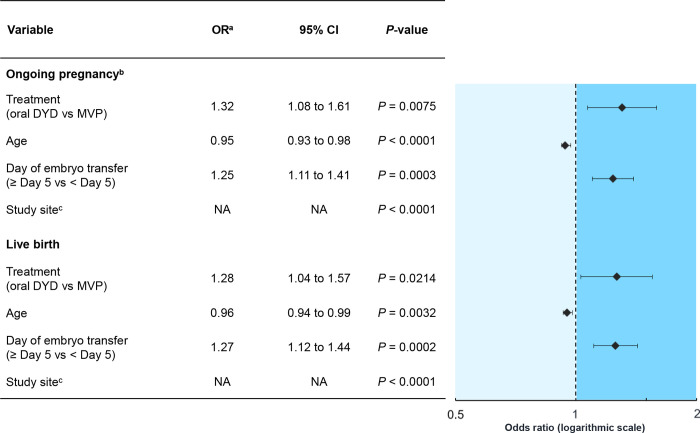
Meta-analysis of IPD: Influence of significant predictor variables (including treatment) on ongoing pregnancy and live birth (FAS).CI, confidence interval; DYD, dydrogesterone; FAS, full analysis sample; IPD, individual participant data; MVP, micronized vaginal progesterone; NA, not applicable; OR, odds ratio. aAdjusted for age, study site, and day of embryo transfer. bAt 12 weeks of gestation. c75 sites in the dataset, resulting in 74 ORs and 95% CIs.